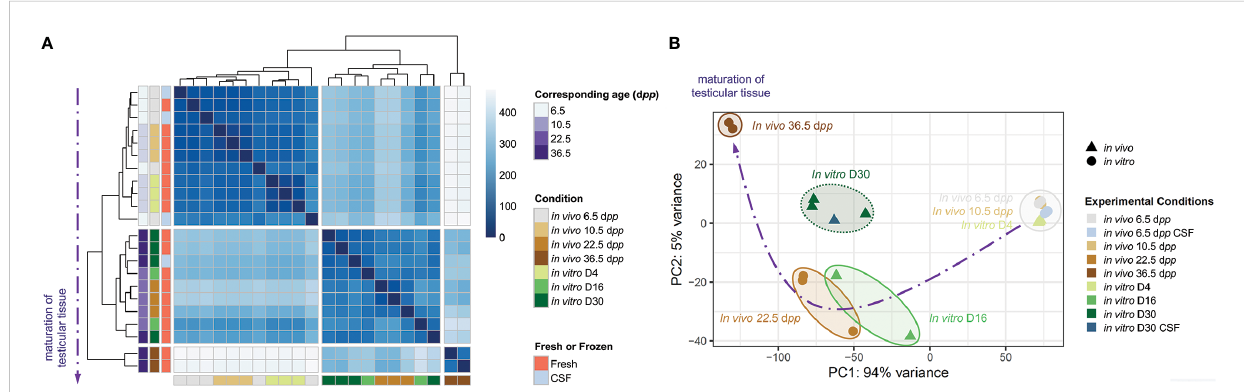
FIGURE 6 Assessment of the maturation of testicular tissue at key stages of the fi rst spermatogenic wave. (A) Correlation map representing all biological samples conditions and repetitions. Each row corresponds to the mean of biological replicate samples: in vivo 6.5 (fresh: n=3; CSF: n=2), 10.5 (n=3), 22.5 (n=3), 36.5 (n=2) d pp ; in vitro D4 (n=3), D16 (n=2), and D30 (fresh tissue: n=3; CSF: n=1). A kinetic evolution curve of the transcriptome of maturing testicular tissues is represented in dotted purple arrow. (B) Principal component analysis (PCA). Representation of the clusters on the map of the gene expression dataset are plotted by the fi rst two principal components (PC) PC1 (94% variance) and PC2 (5% variance). The position of individual samples is indicated in the PCA individual factor map by colored spots which indicate in vivo testicular tissues controls ( ▲ ) and in vitro explants ( ● ) cultured from fresh or frozen tissues. Five separate clusters of samples are represented with ellipse delimitations. CSF, controlled slow freezing; d pp , days postpartum